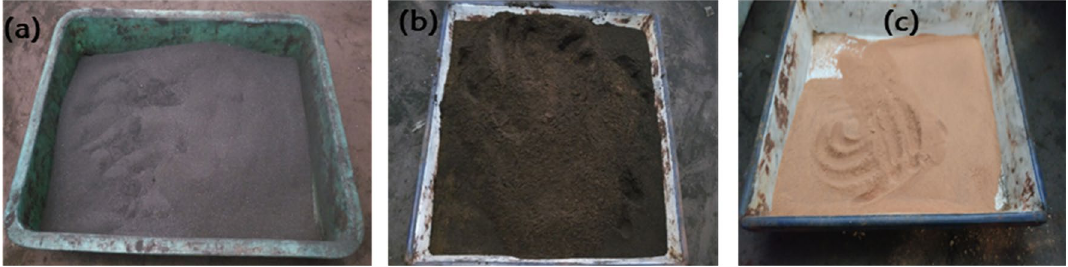
Figure 1. Raw materials ( a ) subbituminous coal, ( b ) torrefied biomass, ( c )